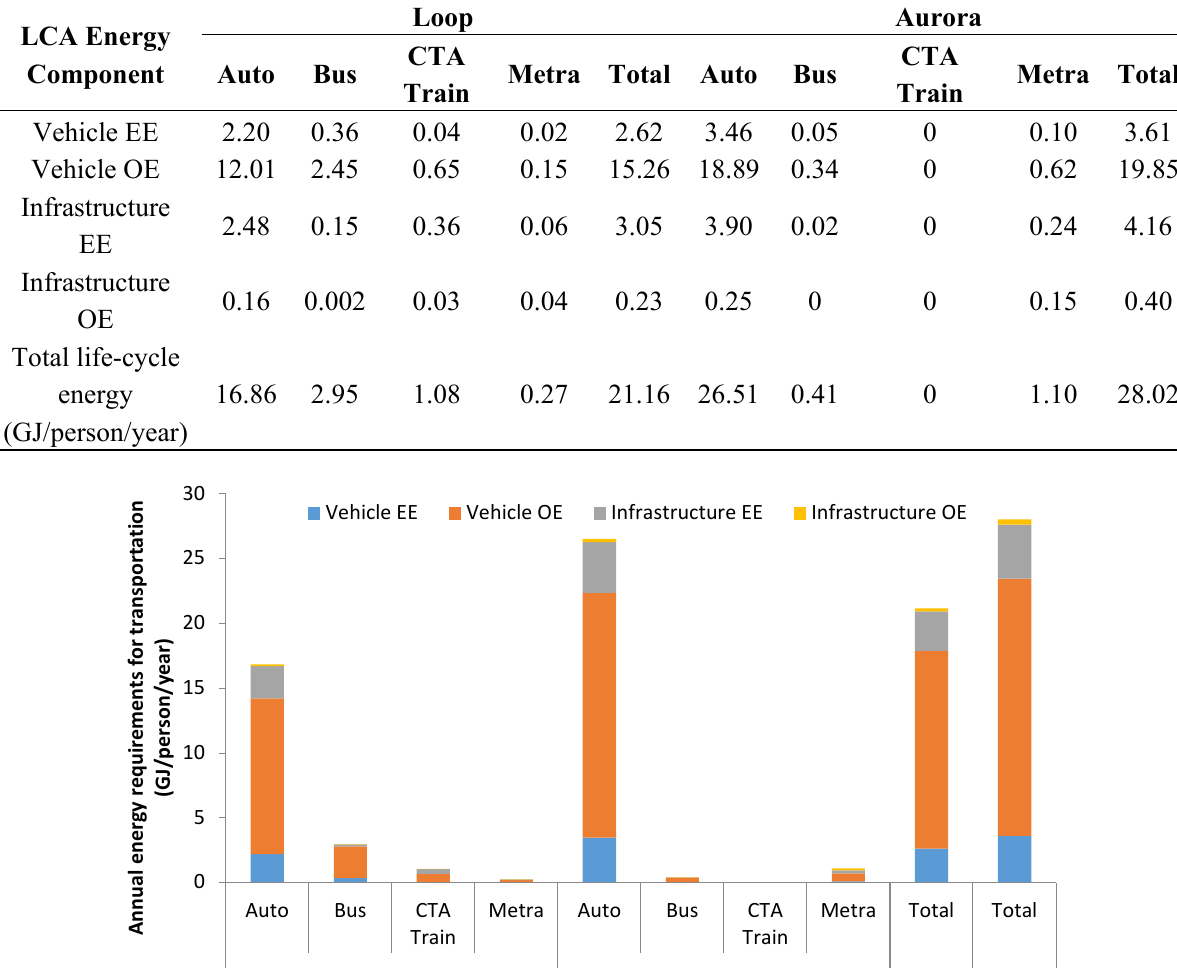
Table 9. Estimates of annual embodied and operational energy (GJ/person/pear) by vehicle and supporting infrastructure for all transportation modes across the two study locations.